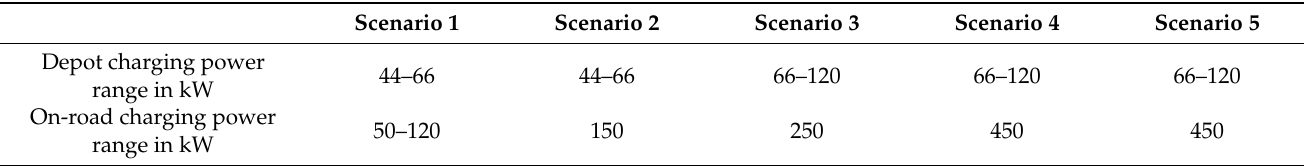
Table 2. Depot and on-road charging power